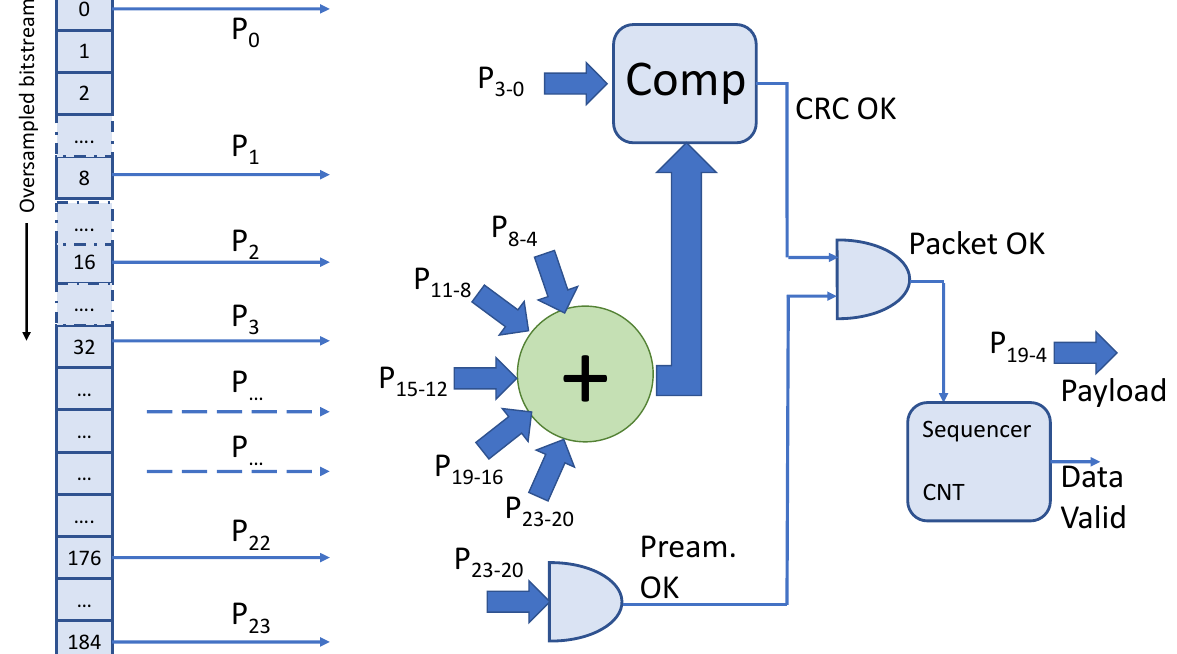
Figure 8. Architecture of the packet reconstruction block integrated in the receiver.